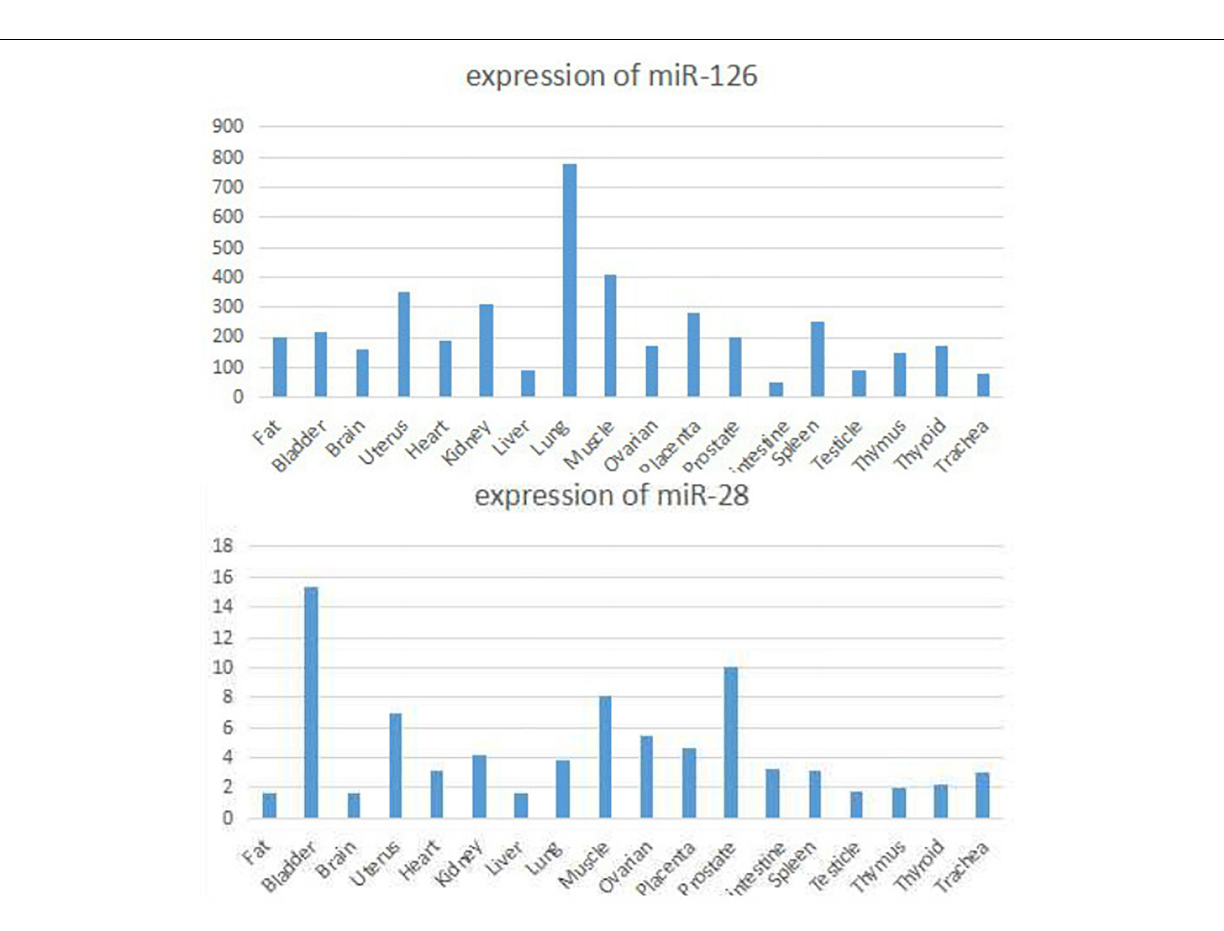
FIGURE 9 | Organ specific expression of miRNA-126 and